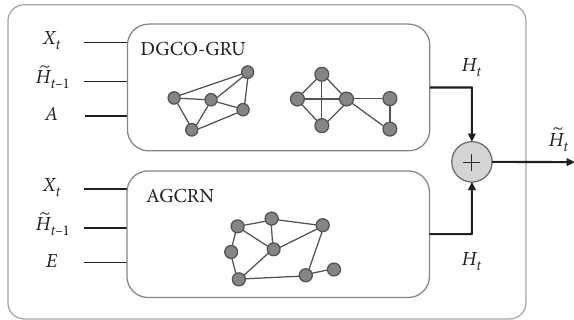
Figure 7: The structure of the